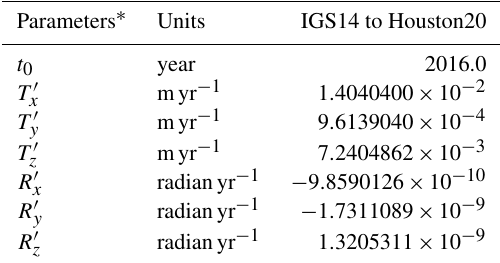
Table 2. Seven Parameters for Realizing